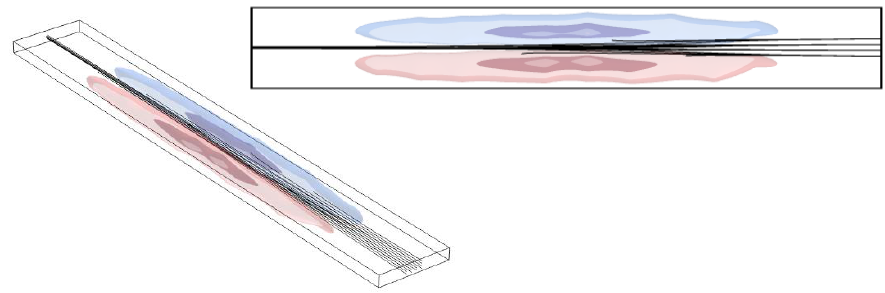
Figure 5. Particle trajectories, with the focusing effect achieved due to the ARF and the drag force (tilted and top view of the microchannel). In this case, the particle diameter is 8 µm.